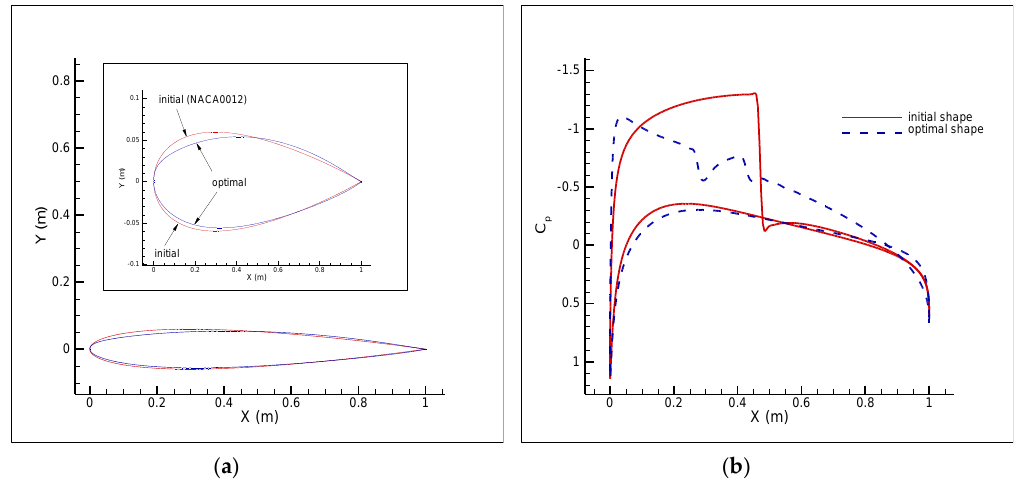
Figure 7. Comparison of initial and optimal airfoils used in the transonic flow shape optimization ( a ) and the corresponding airfoil surface pressure coefficients ( b ).